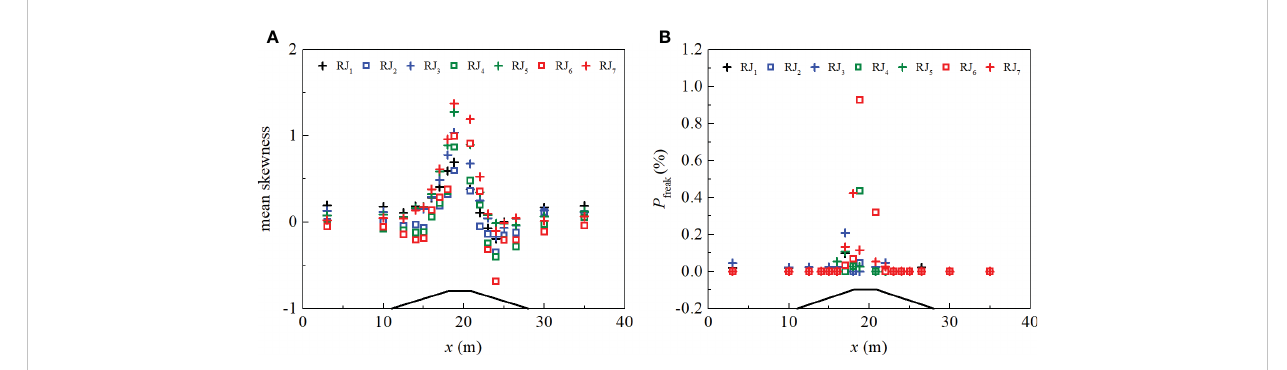
FIGURE 7 The evolutions for the mean skewness (A) and the probability of occurrence for the freak waves (B) .